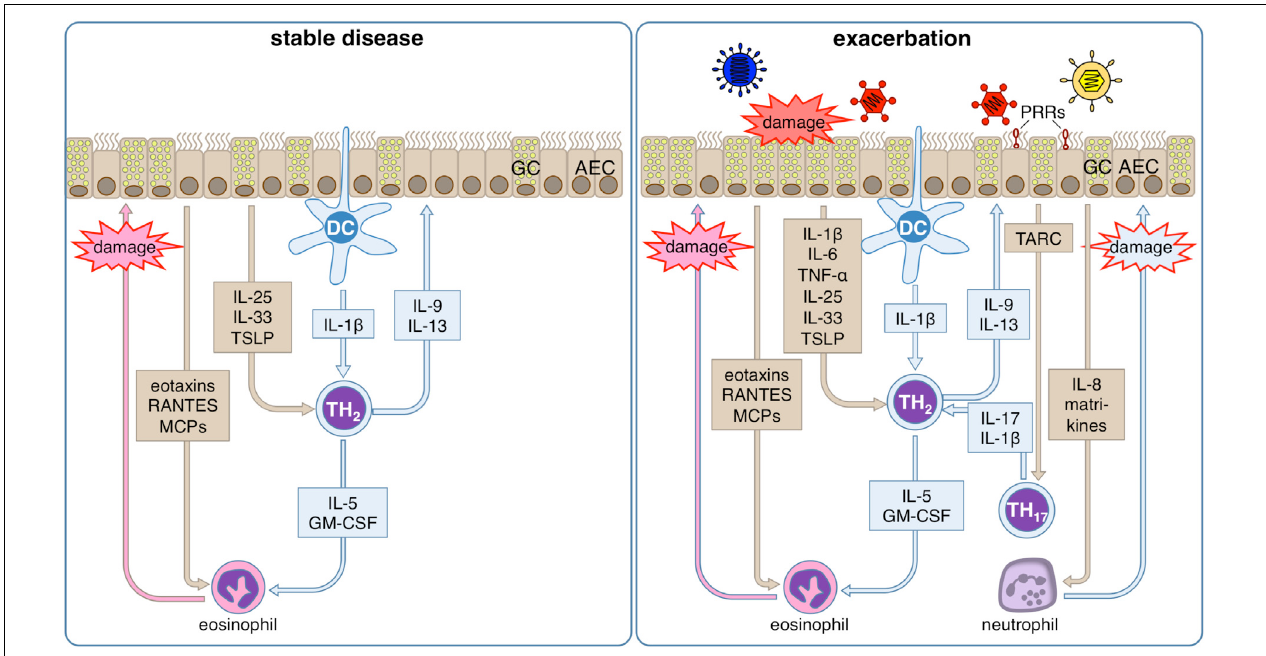
FIGURE 3 | Inflammatory response of the airway epithelium during stable allergic asthma and exacerbation. During stable allergic asthma airway epithelial cells (AECs) release IL-25, IL-33 and TSLP supporting differentiation of T helper (TH) 2 cells that are activated by dendritic cells (DCs). Th2 cells in turn secrete IL-5 and GM-CSF that together with AEC-derived eotaxins, RANTES and MCPs regulate the production, maturation, recruitment and activation of eosinophils. Local degranulation of eosinophils in the lung eventually leads to damage of the airway epithelium. In parallel, the TH2-type cytokines IL-9 and IL-13 induce goblet cell (GC) metaplasia in airway epithelium. During viral induced asthma exacerbations, several other additional factors lead to an aggravation of this inflammatory response. Viral infection can be detected by the airway epithelium via pattern recognition receptors (PRR). Subsequently, AECs secrete on the one hand TARC, the main chemokine for the recruitment of Th17 cells that amplifies the proinflammatory effects of Th2 cells via release of IL-17, and on the other hand IL-8, which leads to the recruitment of neutrophils. Local degranulation of neutrophils in the lung eventually leads to additional damage of the airway epithelium. Viral infection of AECs also directly leads to damage of the airway epithelium. In summary, these conditions result in a markedly increased damage of the airway epithelium compared to the stable disease, which further impairs barrier integrity and leads to release of matrikines further amplifying the ongoing